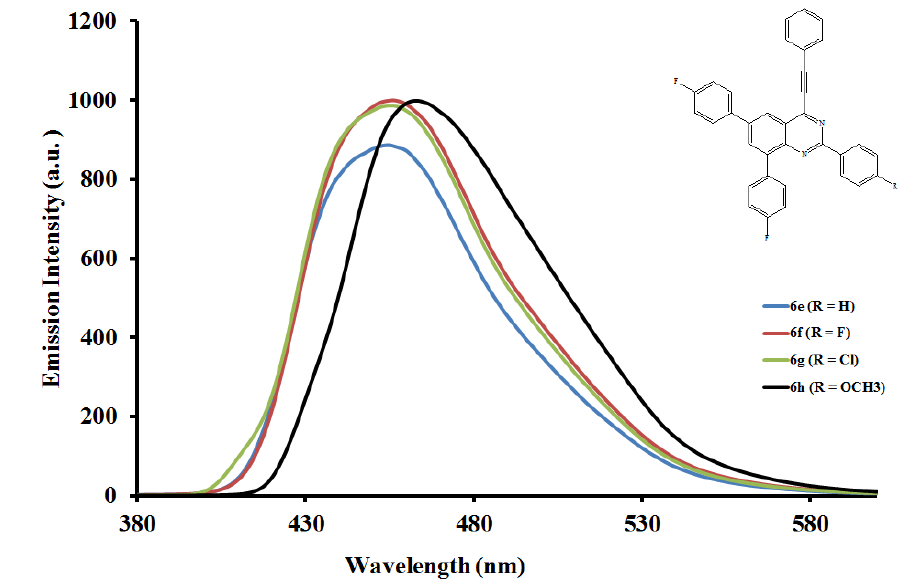
Figure 5. The emission spectra of compounds 6e – h ( λ ex = 380 nm) in CHCl (0.022 mmol/L) at